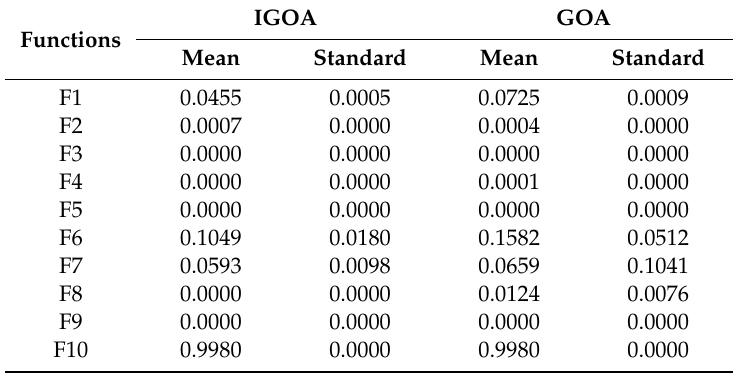
Table 1. The statistical analysis results of benchmark